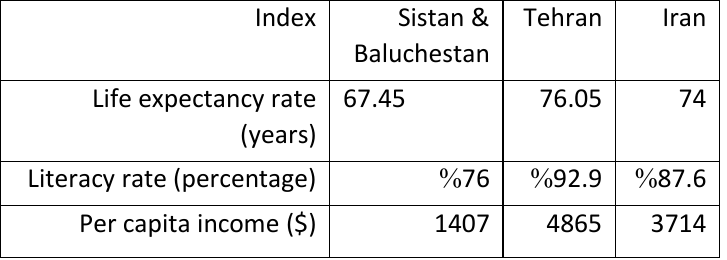
Table 3: HDI data in Iran, Tehran and Sistan & Baluchestan